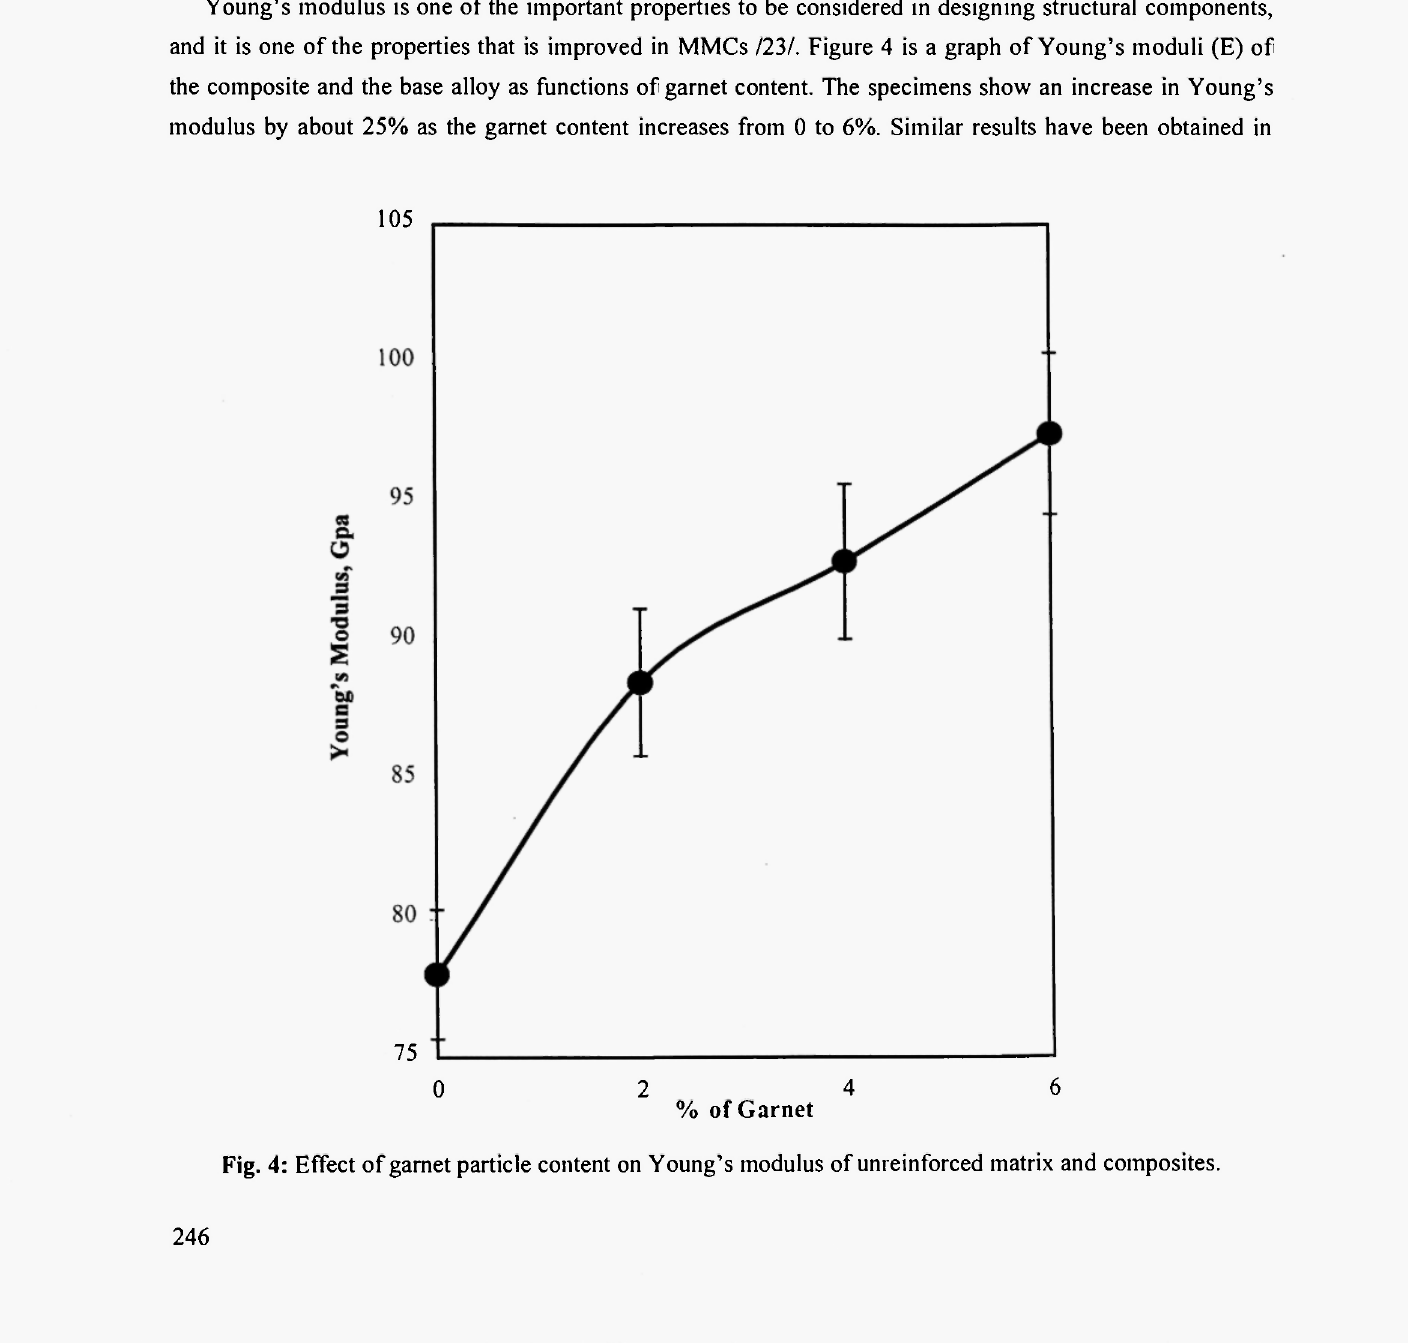
Fig. 4: Effect of garnet particle content on Young's modulus of unreinforced matrix and composites.